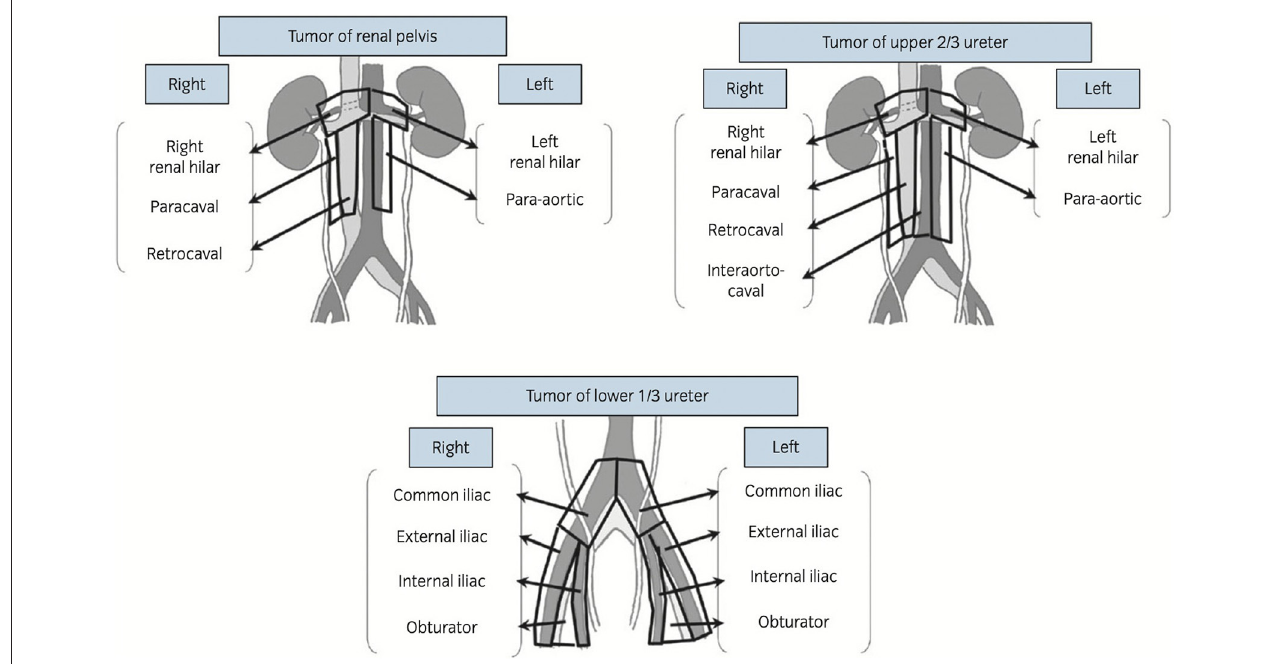
FIGURE 1 | Regional lymphovascular drainage depending on the location of the primary tumors [according to Kondo et al. (37)].